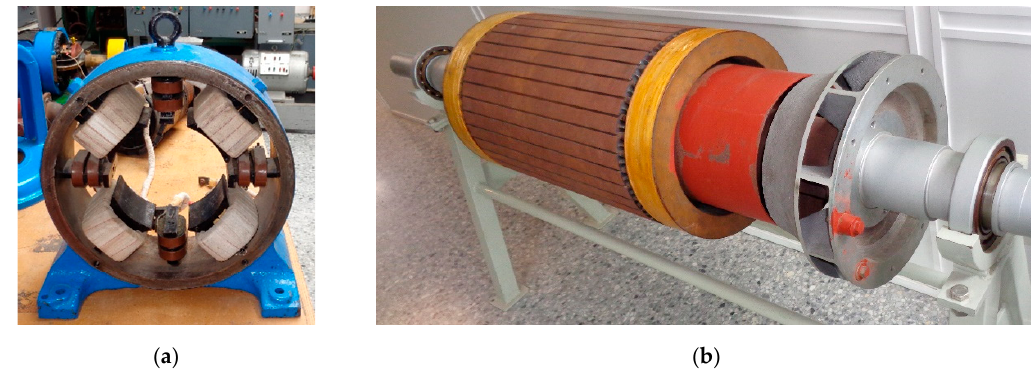
Figure 1 . ( a ) Stator of an electrical machine. ( b ) Rotor of an electrical machine. Figure 1. ( a ) Stator of an electrical machine. ( b ) Rotor of an electrical